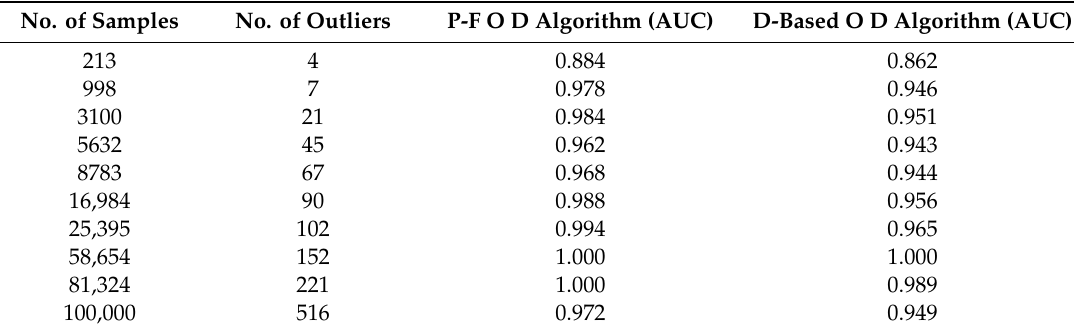
Table 5. Detection of datasets by di ff erent outlier detection algorithms. No. of Samples